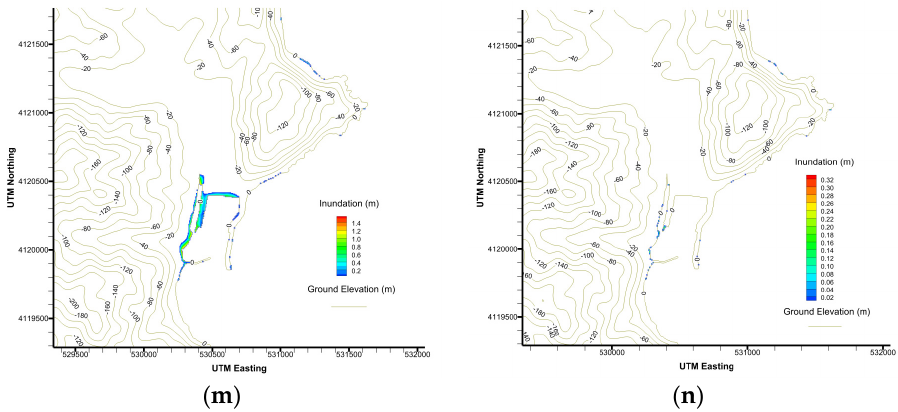
Figure 6. Numerical model results for cases 1–11 and three historical tsunamis. ( a ) 1964; ( b ) 1983; ( c )